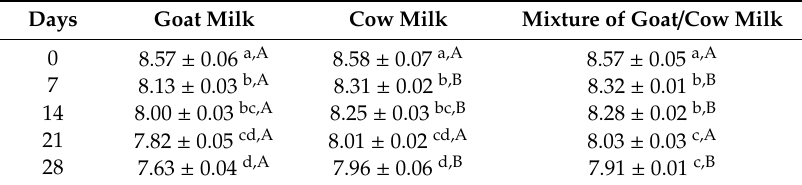
Table 4. Survival (log CFU g − 1 ) of Lactobacillus delbrueckii spp. bulgaricus in fermented milk during refrigerated storage at 4 ◦